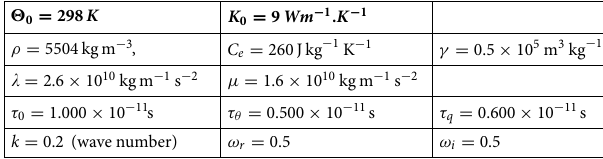
Table 1. Values of the geometrical and the material